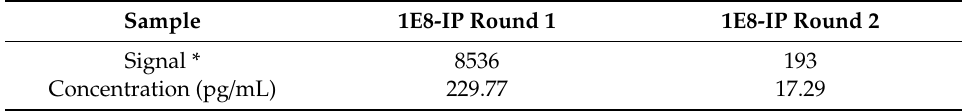
Table 5. E ffi ciency of the 1E8 magnetic bead